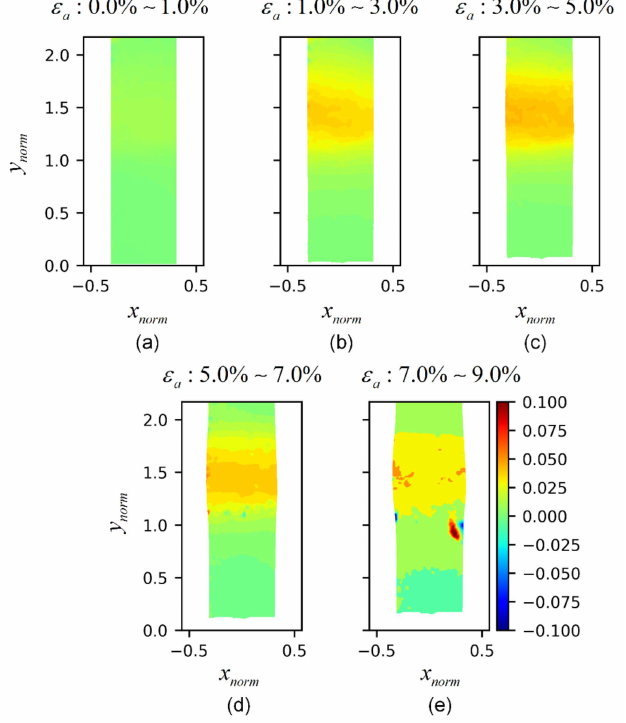
Figure 28. Evolution of gradient along ˆ ρ axis F 11 of test 120704c: ( a ) axial strain 0.0%–1.0%; ( b ) axial strain 1.0%–3.0%; ( c ) axial strain 3.0%–5.0%; ( d ) axial strain 5.0%–7.0%; ( e ) axial strain